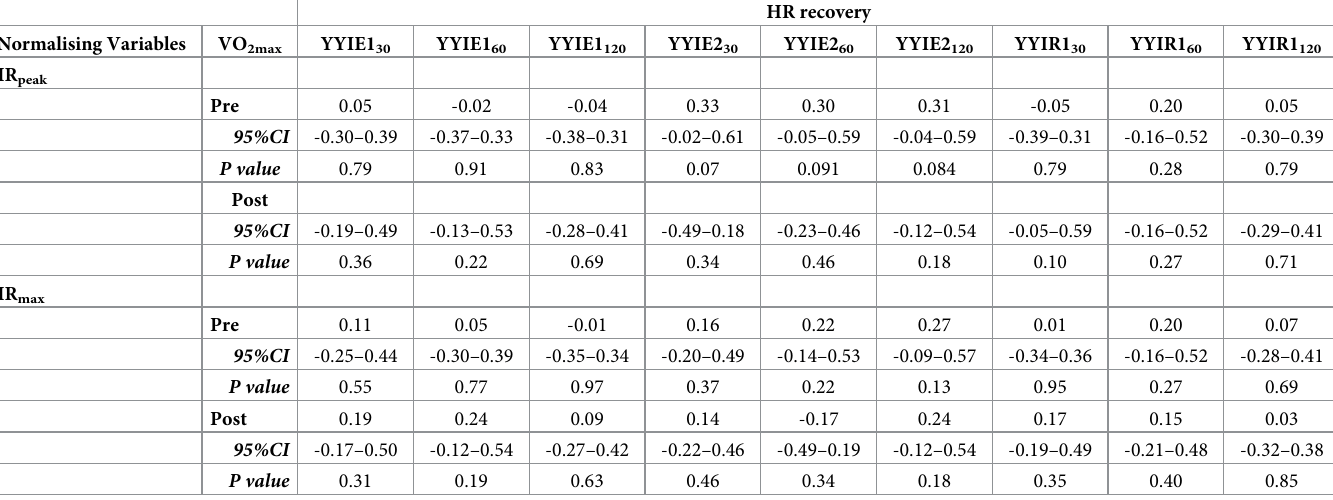
Table 4. Associations between maximal oxygen uptake (VO 2max ) and heart rate (HR) recovery at different time points (i.e., 30, 60 and 120 seconds) after the field tests using the test HR peak (HR peak ) and maximal HR (HR max ) as normalising variables in the untrained (i.e., pre-intervention) and trained state (i.e., post-